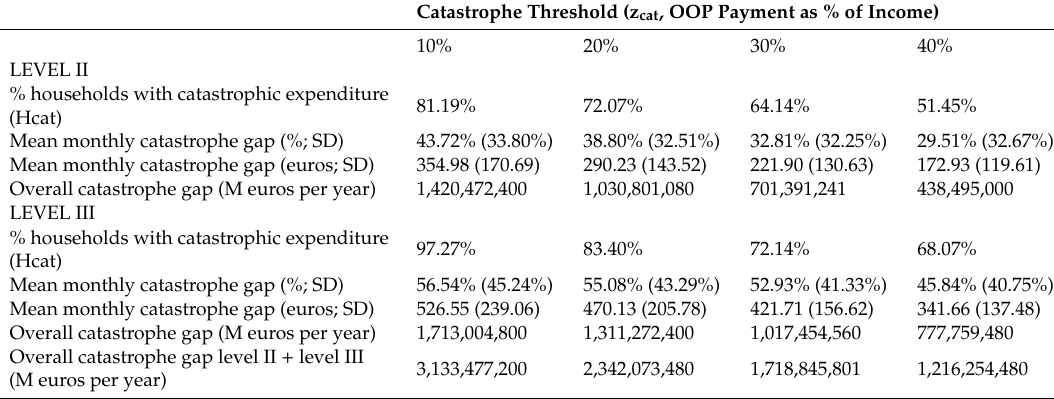
Table 8. Catastrophic e ff ect of dependent care OOP payments by level. Scenario 1 (partial application, including levels II and III).